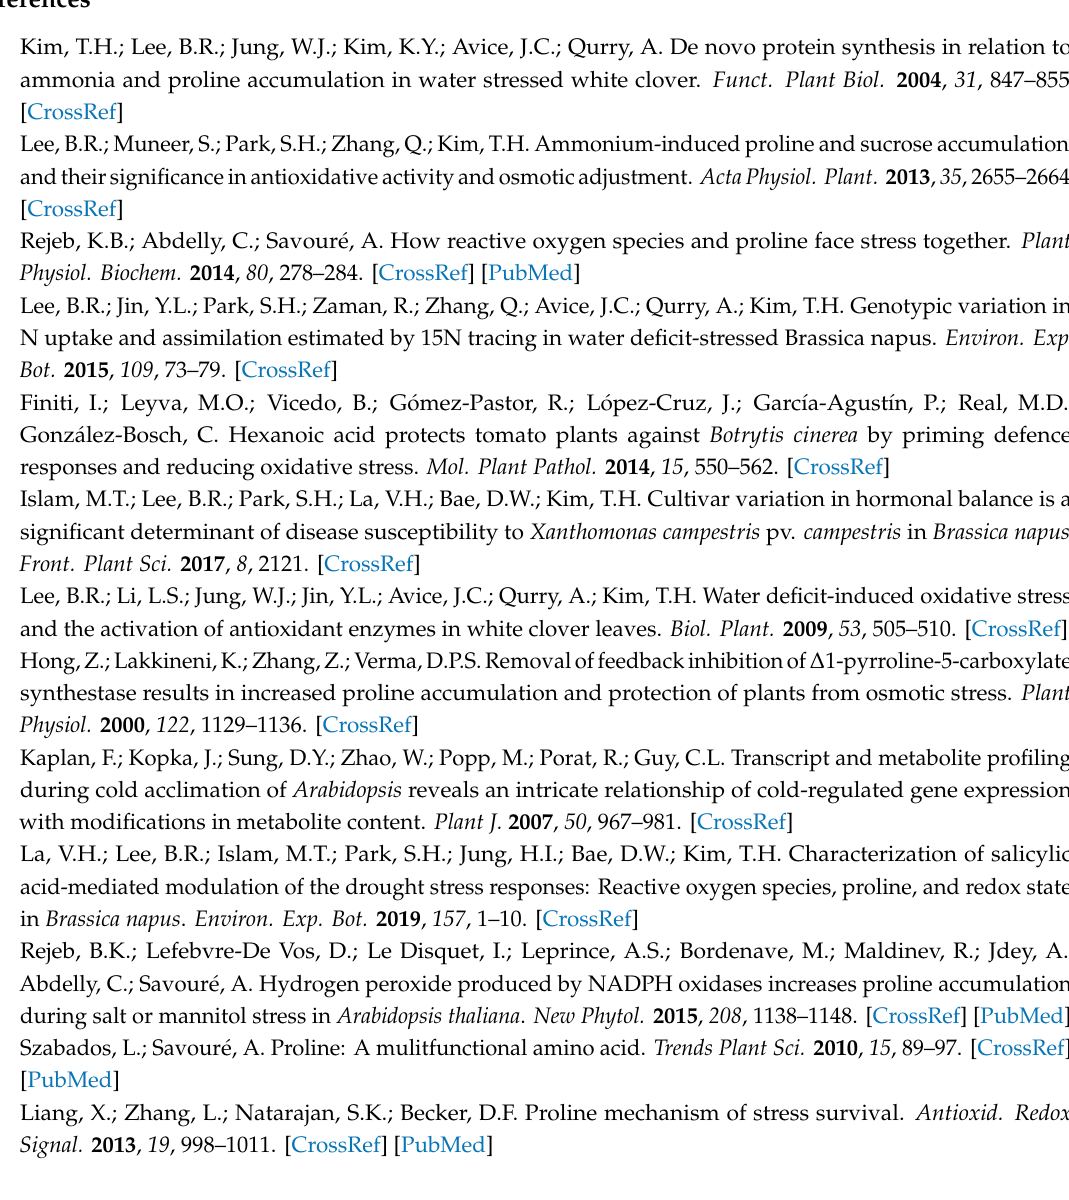
Table S1: (Oligonucleotide primer sequences used for quantitative real-time PCR) and Figure S1: (E ff ect of glutamate (Glu) application on the antioxidative enzymes activity and catalase ( CAT) gene expression in the leaves of Brassica napus under well-watered or drought-stressed conditions), Figure S2: (E ff ect of glutamate (Glu) application on the proline content in phloem and xylem in Brassica napus under well-watered or drought-stressed